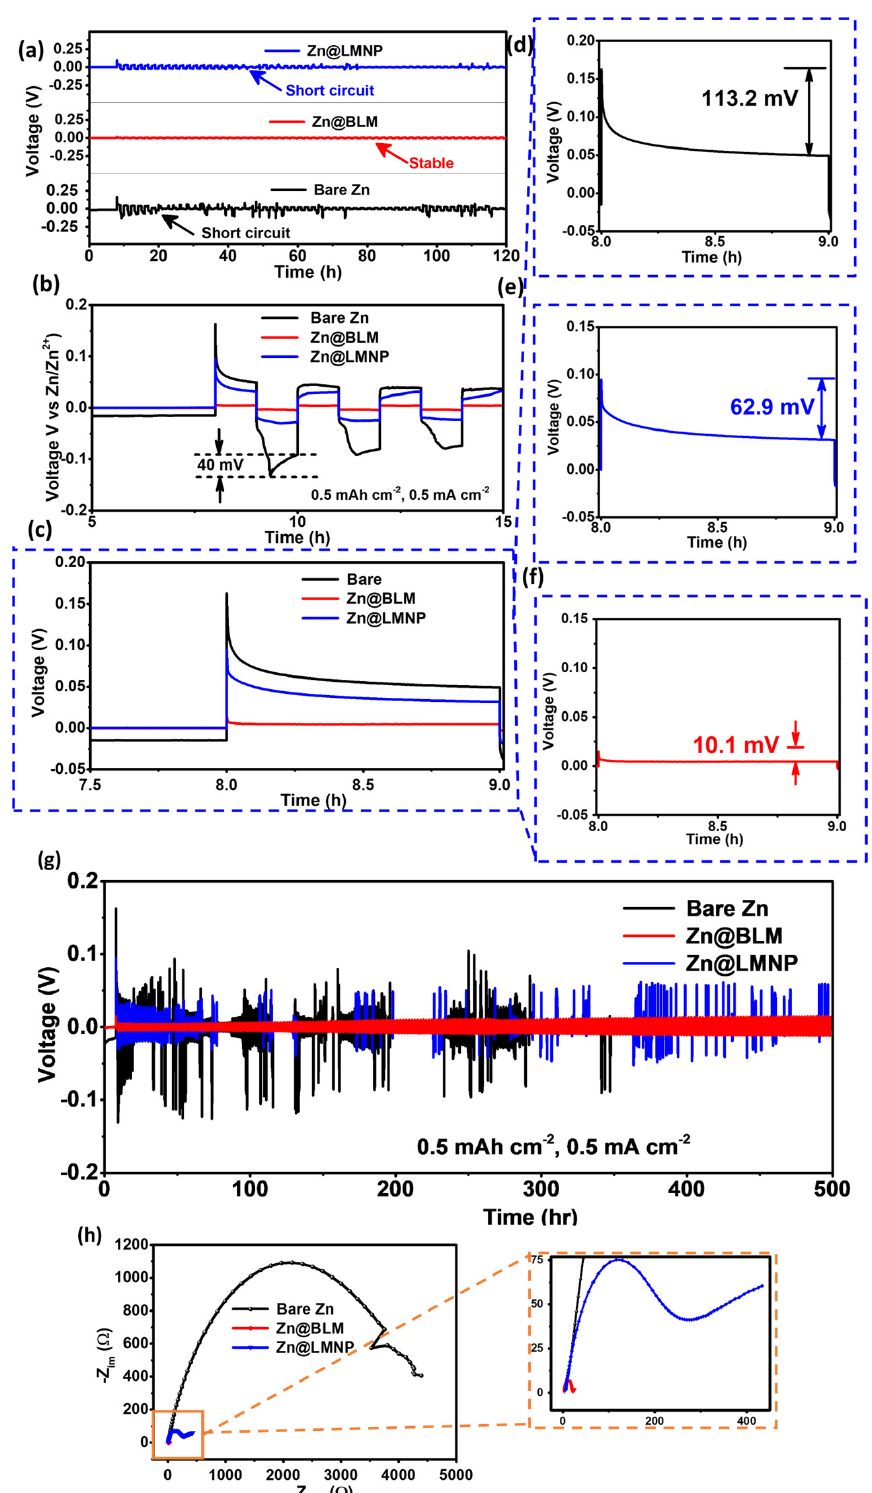
Figure 4. ( a – c ) Charge–discharge voltage behaviors, ( d – f ) corresponding initial nucleation g ) long–term Zn depositing/stripping test of bare Zn||Zn, Zn@BLM||Zn@BLM, and overpotentials, and ( g ) long–term Zn depositing/stripping test of bare Zn||Zn, tentials, and ( Zn@LMNP||Zn@LMNP symmetric cells at 0.5 mA cm − 2 and 0.5 mAh cm − 2 . ( h ) EIS profiles of the symmetric cells after long–term